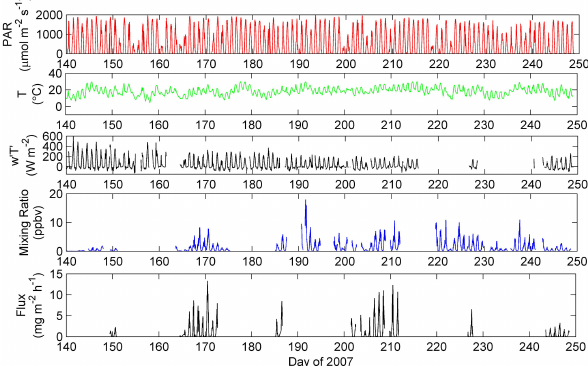
Fig. 2. Isoprene mixing ratio (4th panel) and flux (bottom panel) measurements for 2007. Also shown are photosynthetic photon flux density (PPFD, top panel), temperature (2nd panel), and sensible heat flux (3rd panel) measured at the